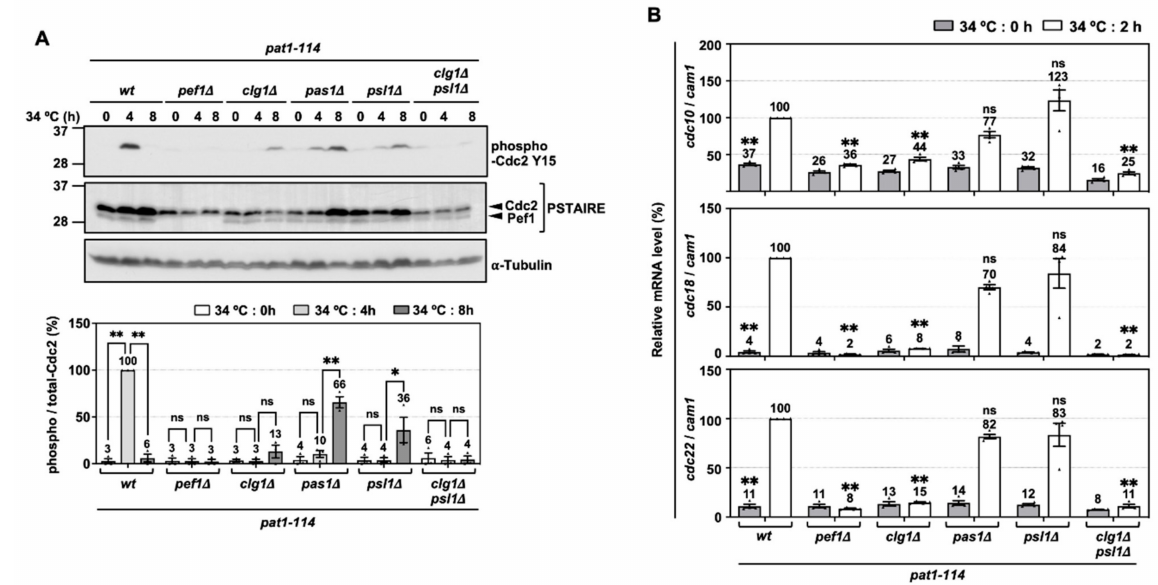
Figure 5. Phosphorylation of Tyr-15 in Cdc2 and expression of DNA replication factors are strongly silenced by deletion of clg1 and psl1 . ( A ) Synchronous meiosis of pat1-114 wt (FY7052), pat1-114 pef1 ∆ (MS030), pat1-114 clg1 ∆ (MS105), pat1-114 pas1 ∆ (MS106), pat1-114 psl1 ∆ (MS107) and pat1-114 clg1 ∆ psl1 ∆ (MS119-1) was induced by nitrogen starvation, followed by temperature shifting from 25 ◦ C to 34 ◦ C. The cells were fixed at the indicated times and then subjected to western blot analysis using anti-phospho-Cdc2 Y15 and anti-PSTAIRE antibodies. α -Tubulin was monitored as a loading control. The graph indicates the percentages of normalized phosphorylated Cdc2 Y15. The results are expressed as means ± SEM from three independent experiments. The intensity of the normalized band in pat1-114 pef1 + + pREP273-vector at 4 h is taken as 100%. ** p < 0.01; * 0.01 < p < 0.05; ns, not significant p > 0.05 (ANOVA). ( B ) Total RNA extracted from meiosis-induced cells reverse-transcribed to cDNA and subjected to RT-qPCR analysis. cam1 was used as a loading control. The results are expressed as means ± SEM from three independent experiments. The normalized mRNA level in pat1-114 pef1 + + pREP273 vector at 2 h is taken as 100%. ** p < 0.01; * 0.01 < p < 0.05; ns, not significant p > 0.05